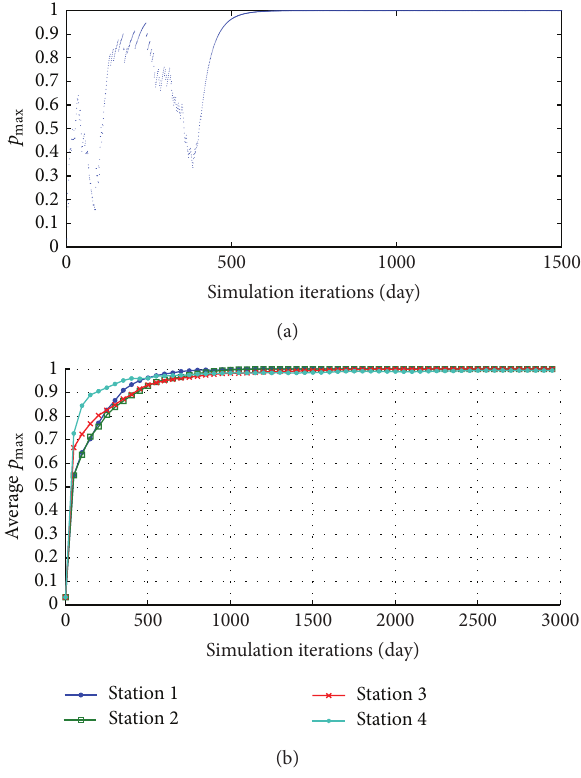
Figure 6: (a) One commuter’s 𝑝 max , (b) commuters’ average 𝑝 max .